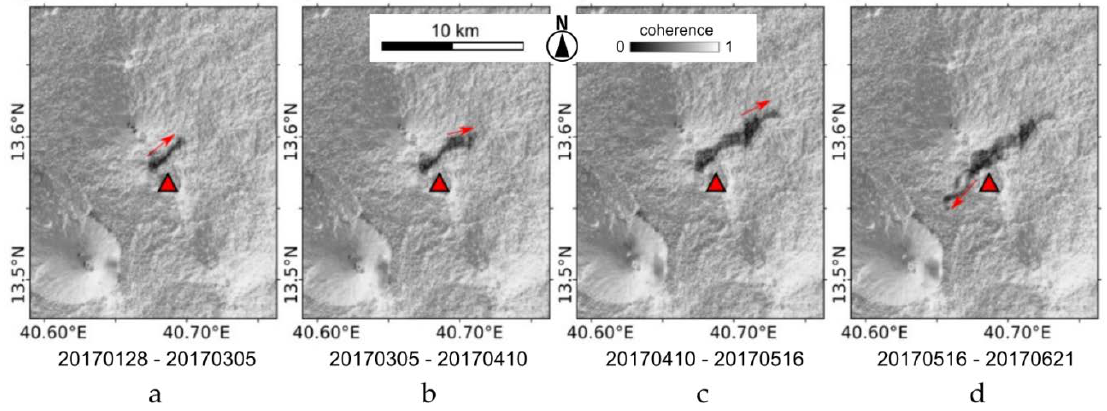
Figure 13. Coherence time series at Erta Ale showing the emplacement of the lava flow during the early stage of the 2017 eruption, from InSAR combinations (having 36-days temporal difference) between: ( a ) 20170128–20170305, ( b ) 20170305–20170410, ( c ) 20170410–20170516, ( d ) 20170516– 20170621. The red triangle locates the volcanic edifice and the red arrows indicate the direction of propagation of the lava flow for each period.